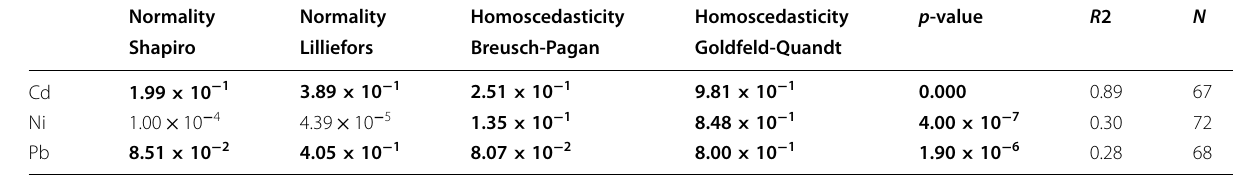
Significant results are indicated in bold